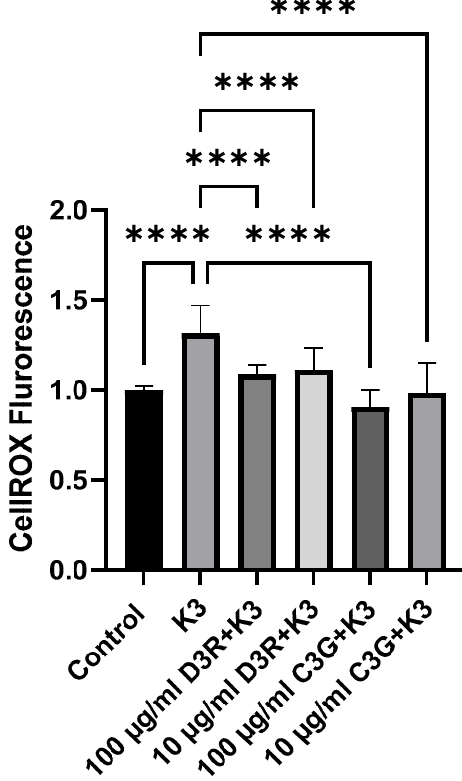
Figure 6. Effects of anthocyanins on oxidative stress in BV-2 cells. Shown are results of CellROX TM fluorescence from experiments ( n = 3) demonstrating the effect of two different anthocyanins, D3R and C3G, on K3-induced oxidative stress in BV2 cells. Both D3R and C3G inhibited K3-induced oxidative stress in BV-2 cells at concentrations of 100 µg/mL and 10 µg/mL (**** p < 0.0001).